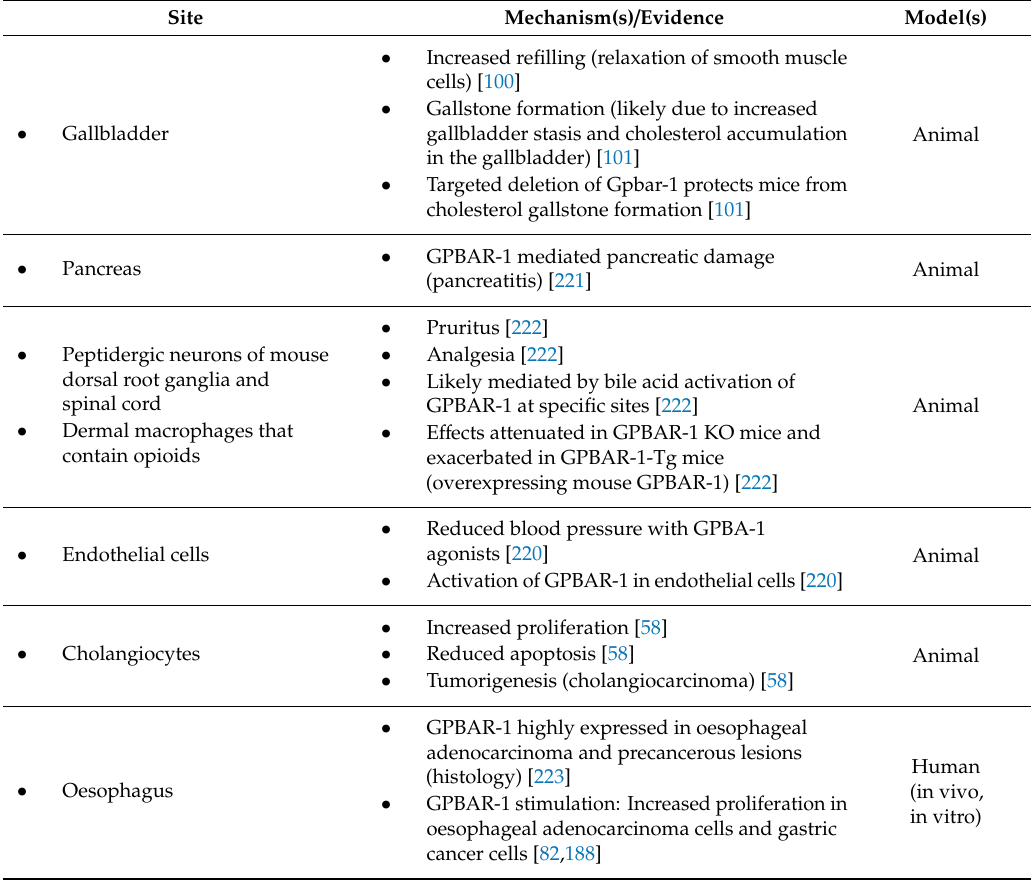
Table 6. Potential drawbacks associated with GPBAR-1